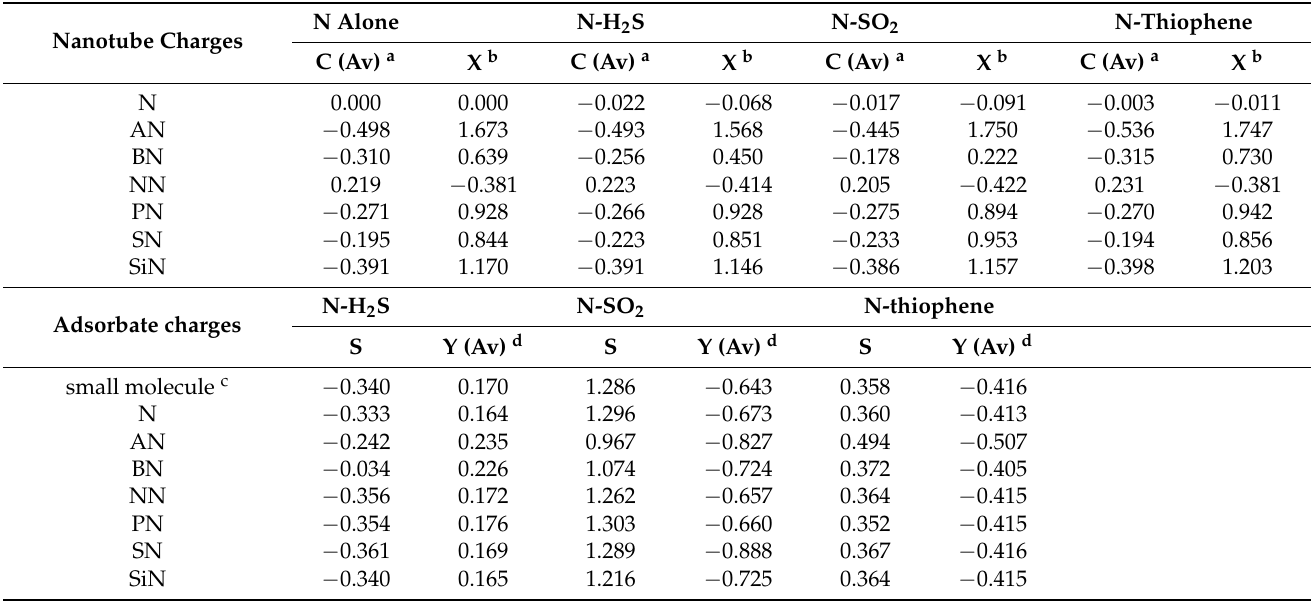
Table 3. NBO atomic charges (in atomic units) for all adsorbents, adsorbates, and